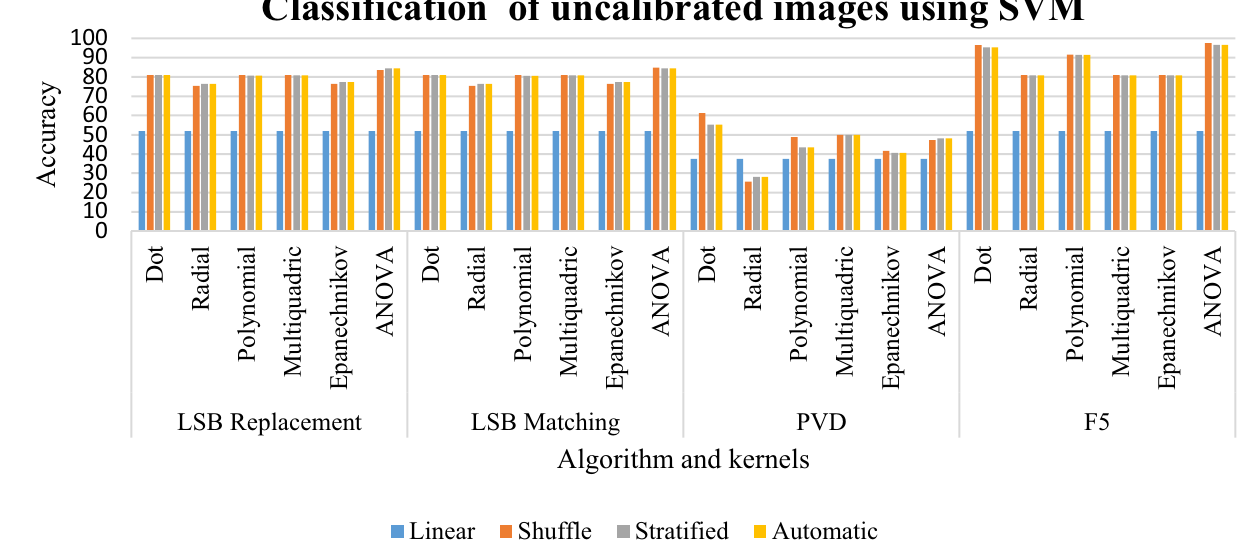
Graph 1. Result of classification of uncalibrated images using SVM for random %.